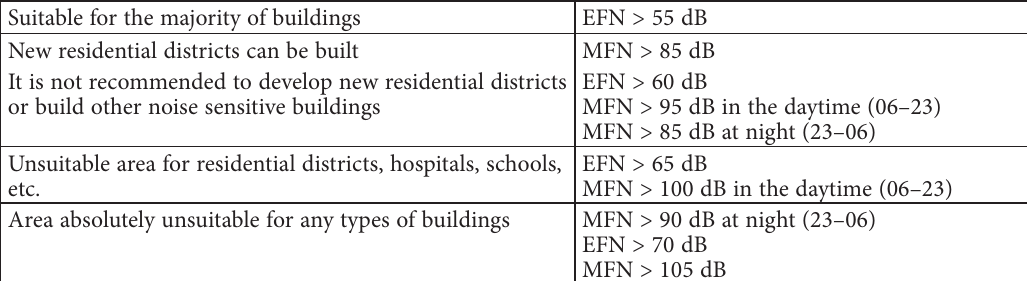
Table. Noise zones at Tallinn Airport